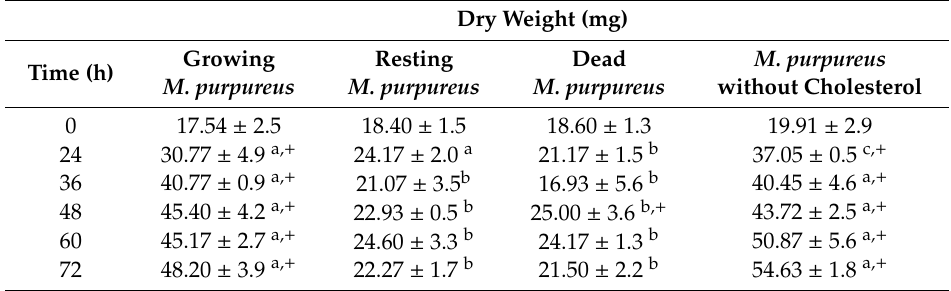
Table 2. Dry weight of M. purpureus CBS 109.07. Growing, resting, or dead M. purpureus cultures were incubated in 120 µ g / mL cholesterol and 0.3% ( w / v ) oxgall bile salts at 37 ◦ C. M. purpureus incubated without cholesterol served as a control. Three independent trials, corresponding to samples used for cholesterol assimilation, were conducted for each growth phase at each time